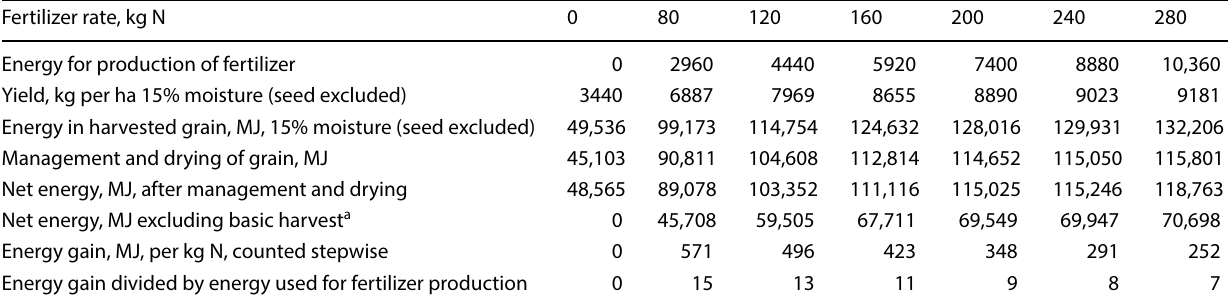
Table 5 Estimated energy outputs in harvested winter wheat, energy inputs for cultivation and drying of grain, and net yield of energy